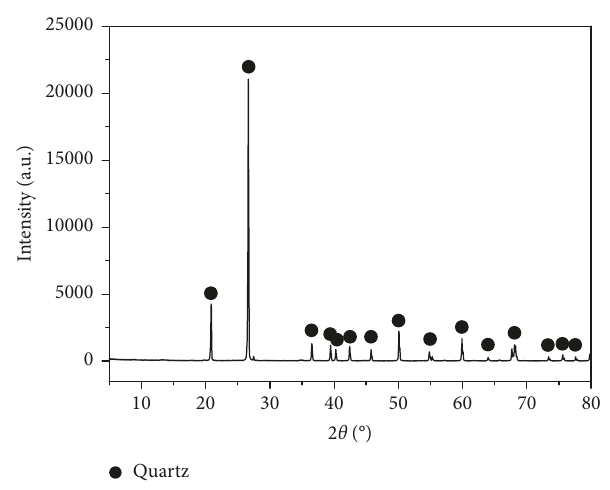
Figure 2: XRD pattern of SS.